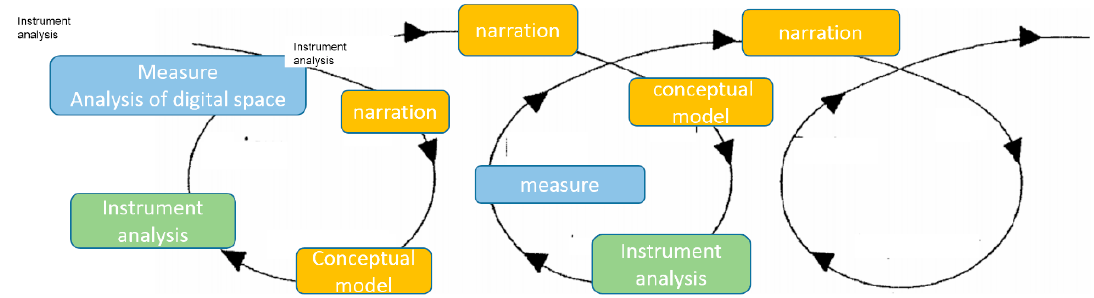
Figure 7. The iterative structure of the proposed methodology.